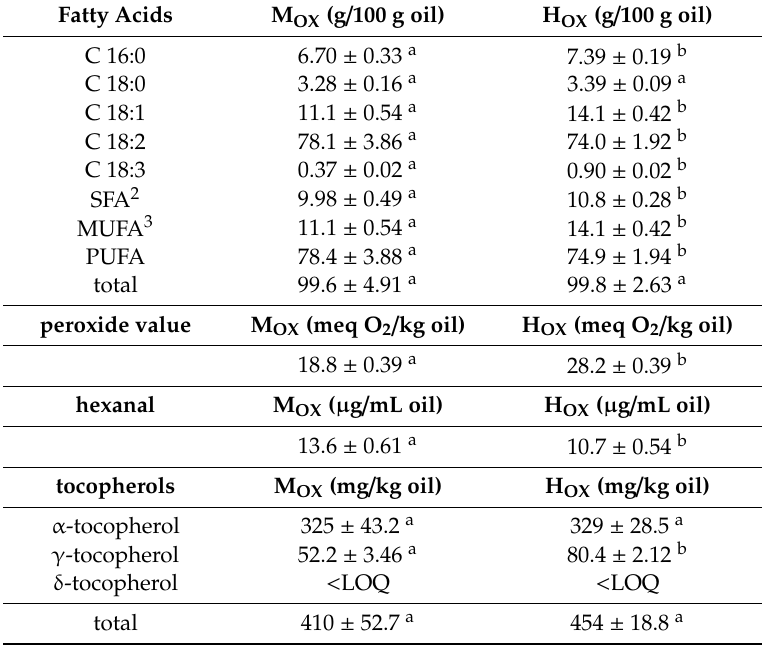
Table 1. Characterization of the cold-pressed grape seed oils regarding their fatty acid compositions (g / 100g oil), peroxide values (meq O 2 / kg oil), hexanal ( µ g / mL oil) and the amount of tocopherols (mg / kg oil) 1